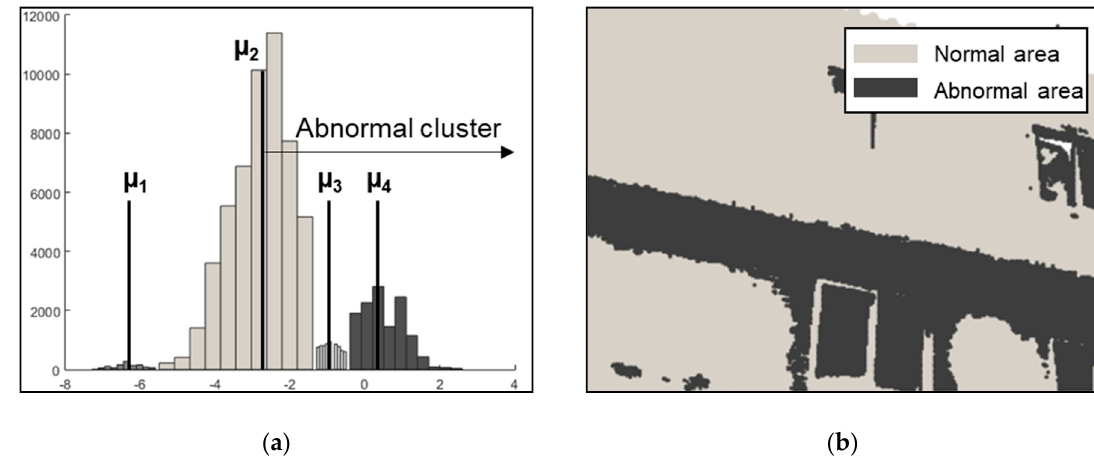
Figure 3. Thermal anomaly cluster classification: ( a ) criterion to classify abnormal cluster and ( b ) segmentation result.